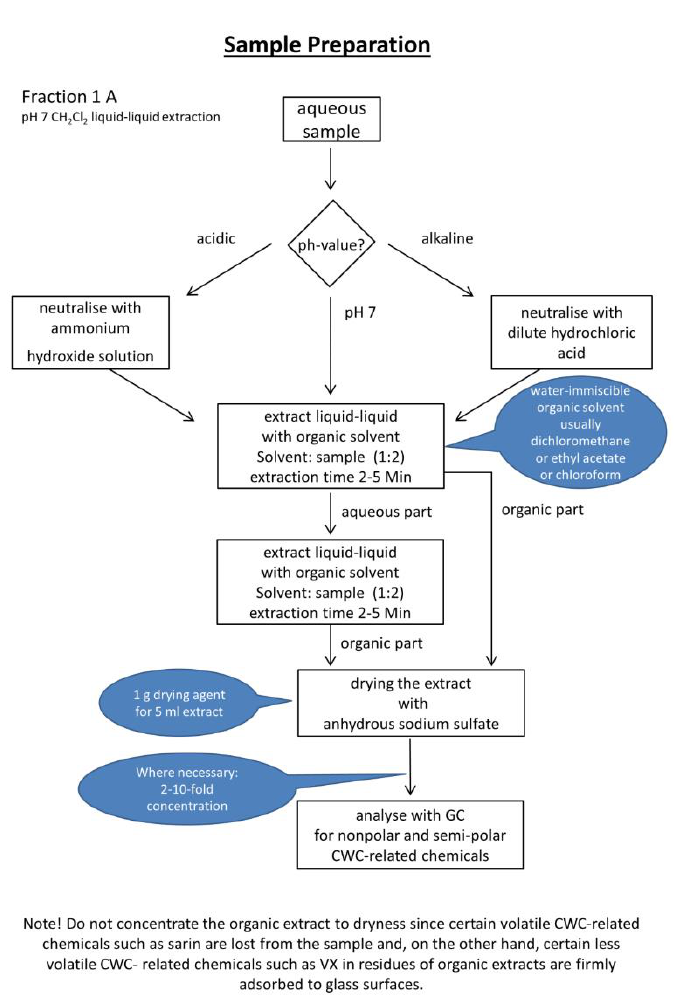
Figure A1. Recommended operating procedure according to the blue book for the processing of liquid-liquid extraction at neutral conditions.